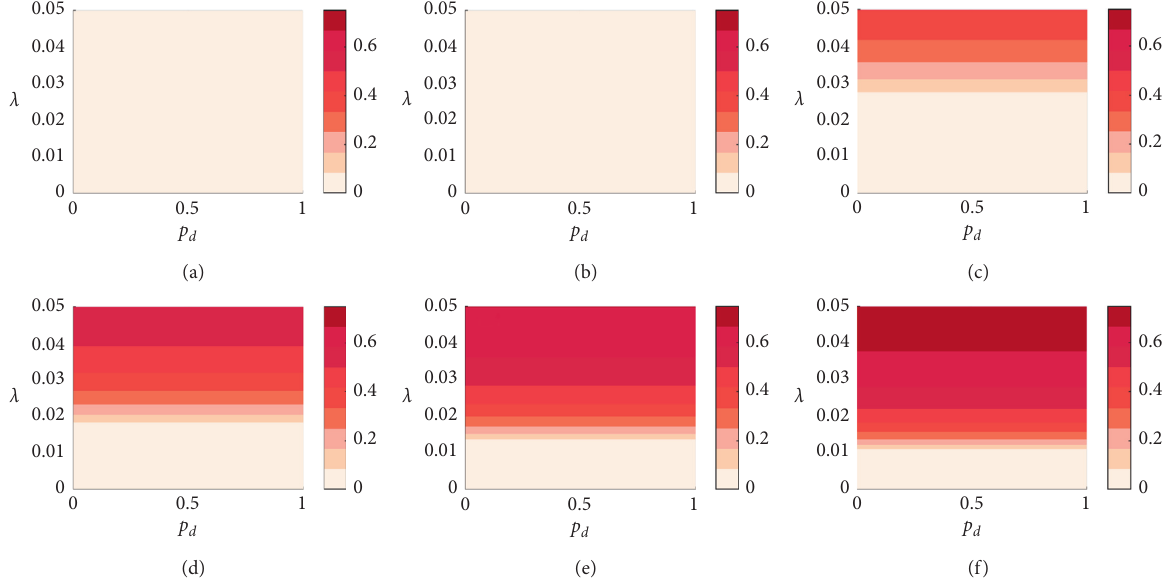
Figure 3: The financial risk information spreading on metapopulation on ( p a function of travelling probability p d and information transmission probability λ with α � 0 (a), α � 0 . 2 (b), α � 0 . 4 (c), α � 0 . 6 (d), α � 0 . 8 (e), and α � 1 (f). Different colors represent the values of 〈 ρ 〉 .